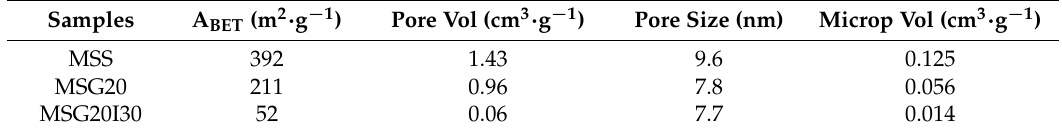
Table 2. Textural properties calculated from N 2 adsorption/desorption isotherms. Samples